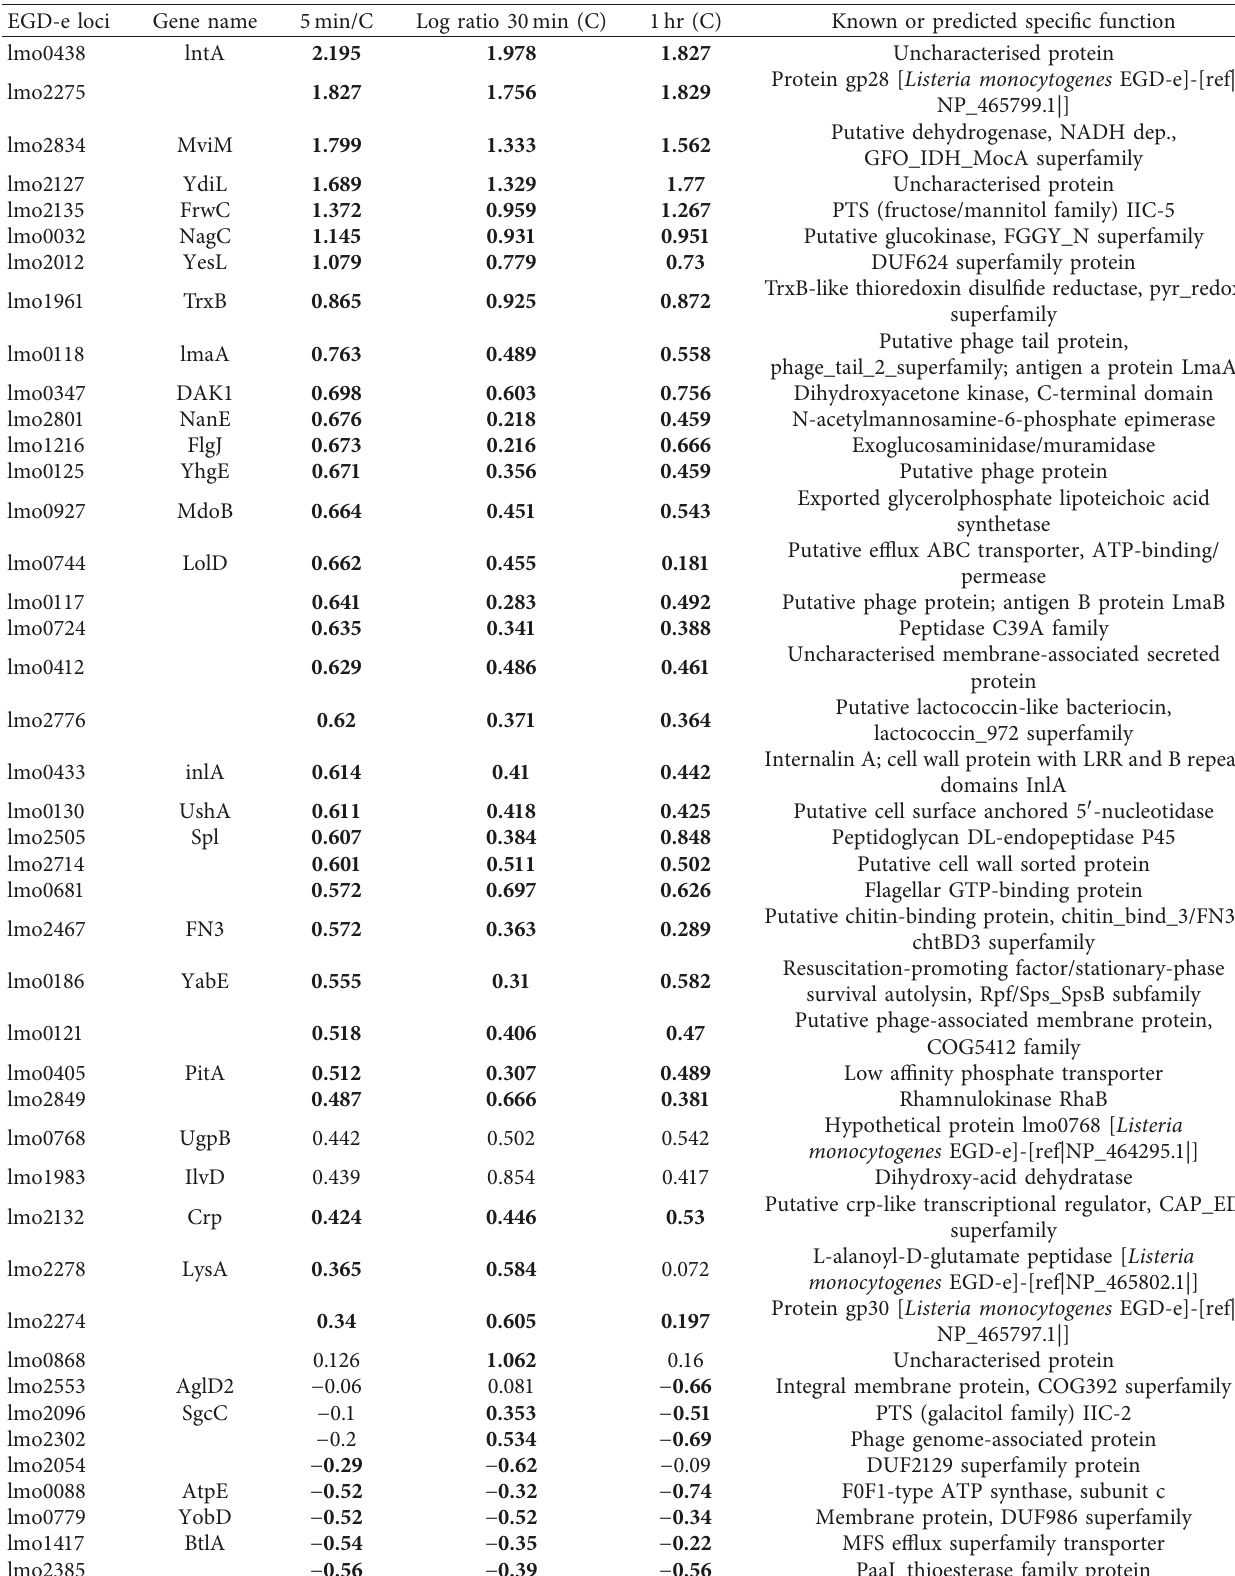
Table 1: Whole proteome analysis of L. monocytogenes ATCC 19115 responses to acidic and hyperosmotic stresses in a time-course study. EGD-e